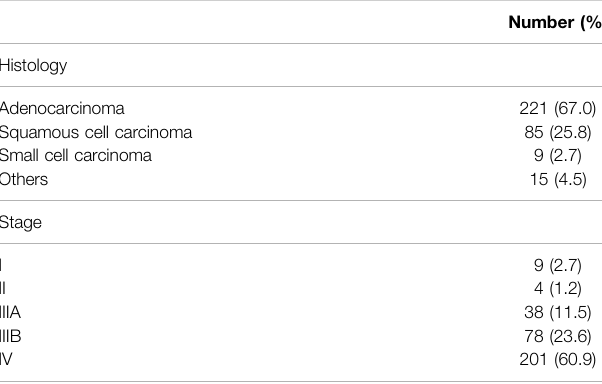
TABLE 2 | Baseline clinicopathology and stage characteristics for patients with lung cancer.